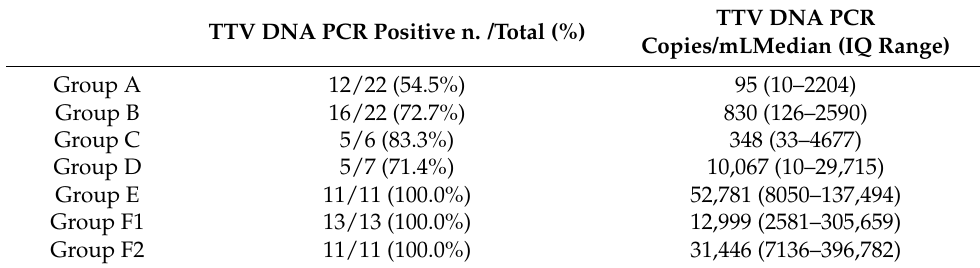
Table 3. Association of TTV DNA positivity and copies/mL with subgroups of patients. TTV DNA PCR Positive n. /Total